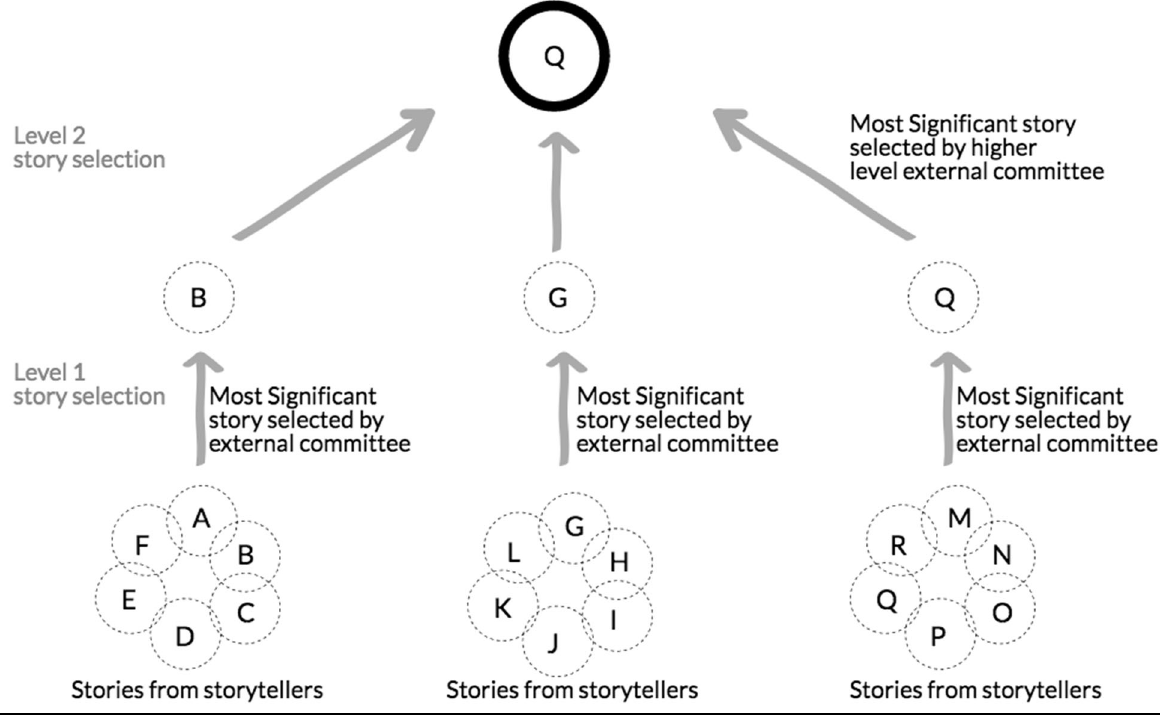
Source: Adapted from Dart and Davies (2003, p.